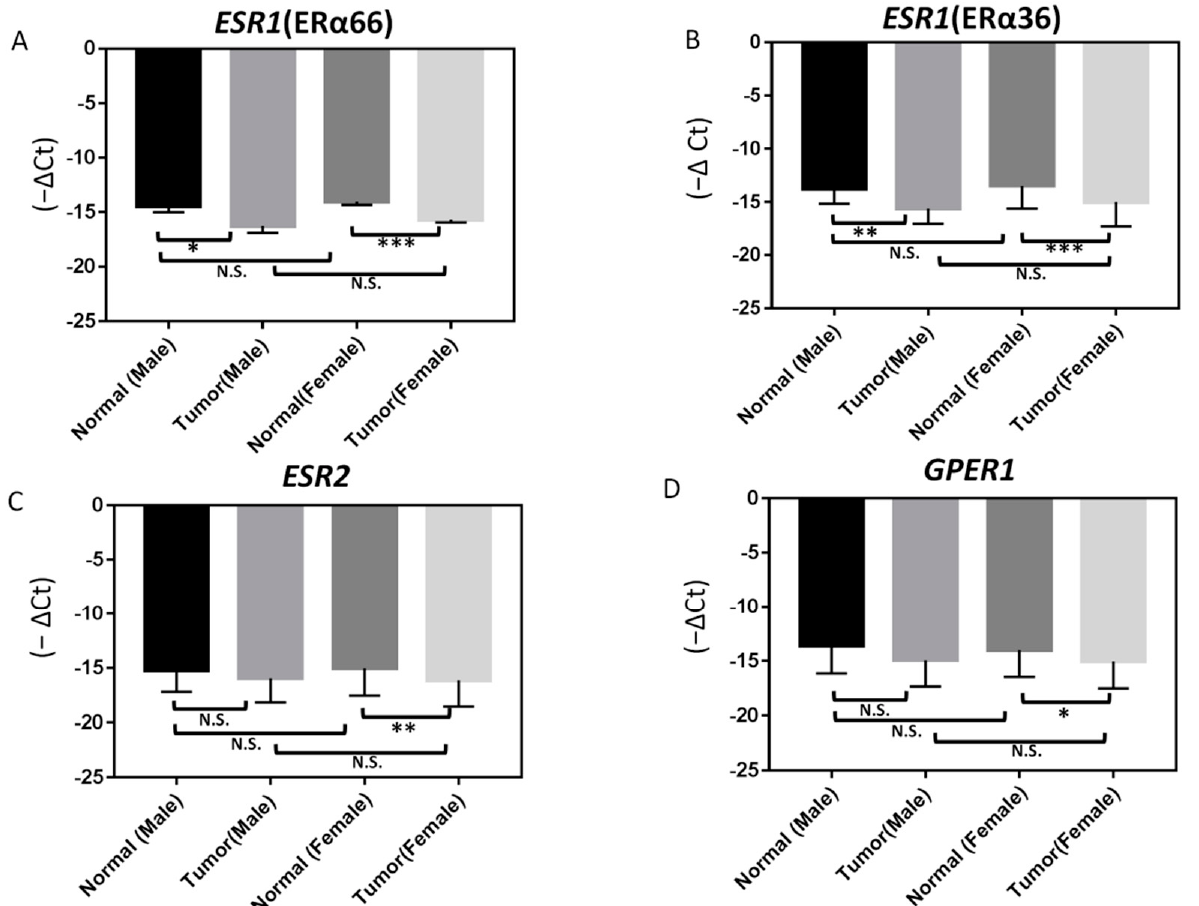
Figure 2. The majority of patients with PTC show lower ERs expression in cancer specimens than in adjacent normal thyroid tissues. Relative mRNA expression levels of ( A ) ER α 66, ( B ) ER α 36, ( C ) ER β , and ( D ) GPER1 in PTC ( n = 103) samples normalized to that in adjacent normal tissues (T/N fold change). The pie charts show the proportion of samples with upregulated, downregulated, and un- detectable expression .